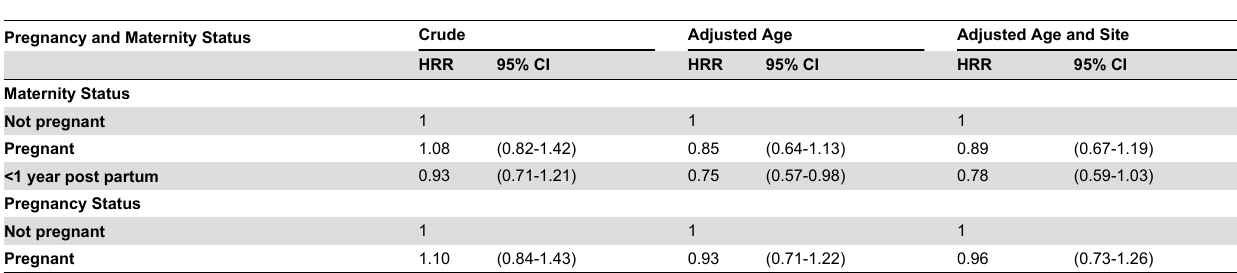
Table 4. Incident rate ratio comparing pregnancy status for pre PMTCT period.